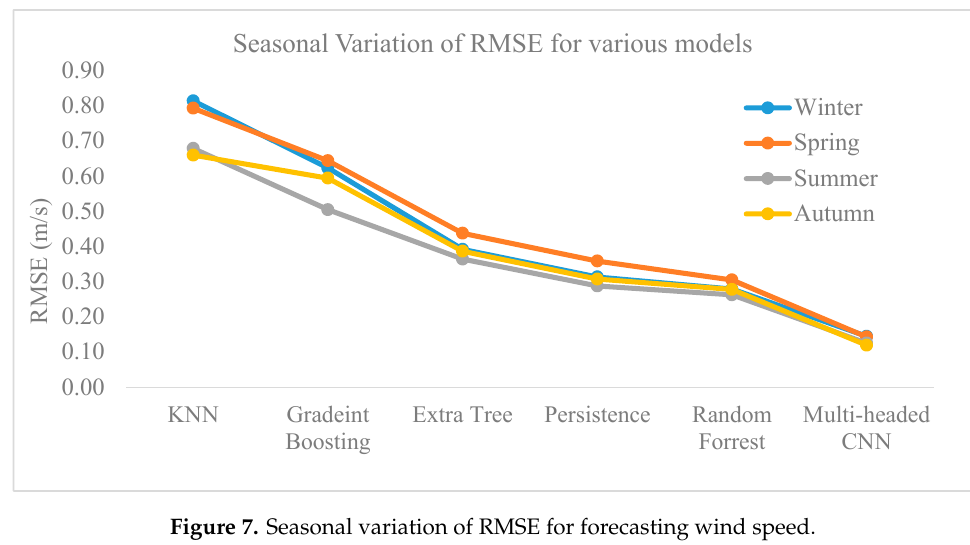
Figure 7. Seasonal variation of RMSE for forecasting wind speed.